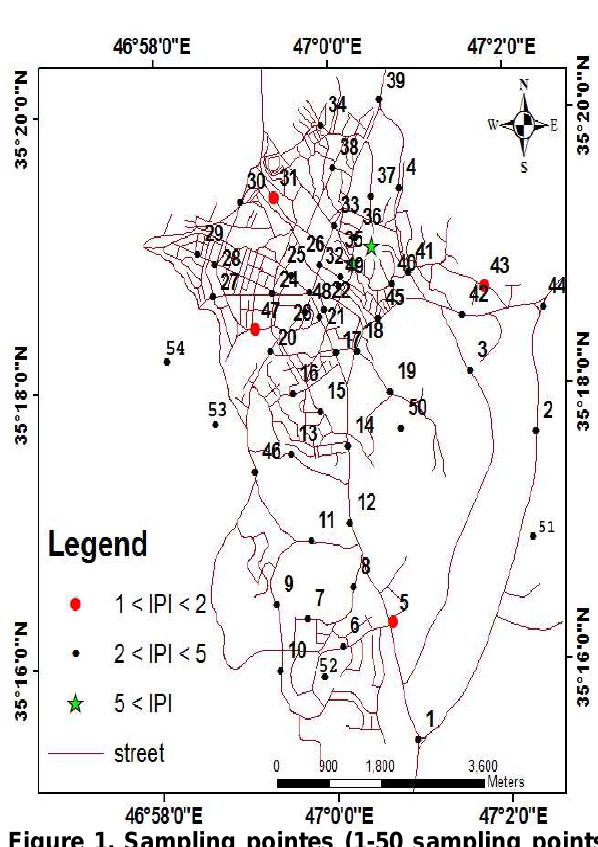
Figure 1. Sampling pointes (1-50 sampling points and 51-55 control points) and spatial distribution of the integrated pollution index (IPI) in the studied